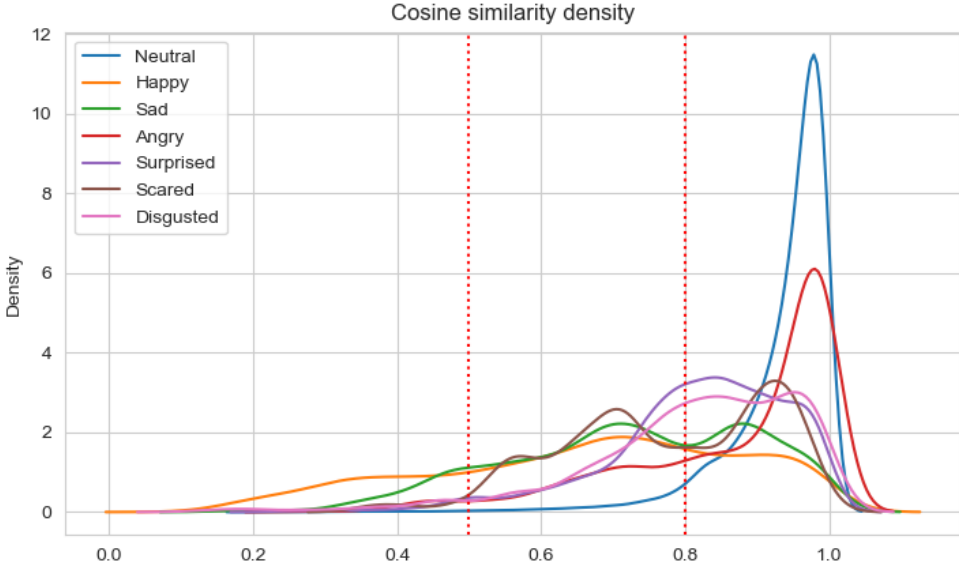
Figure 9. Density plot for Ekman’s emotions with neutral state in Experiment 5.